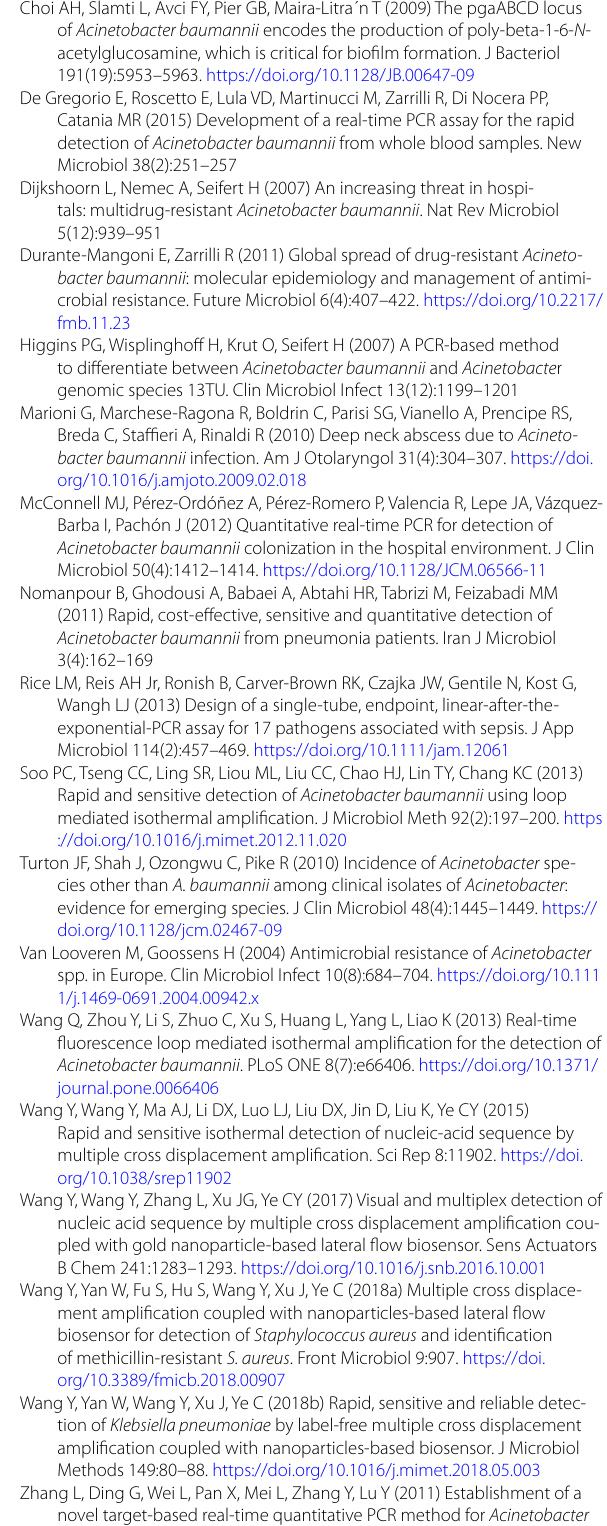
Table 3 Comparison of methods for detection of A. baumannii in sputum